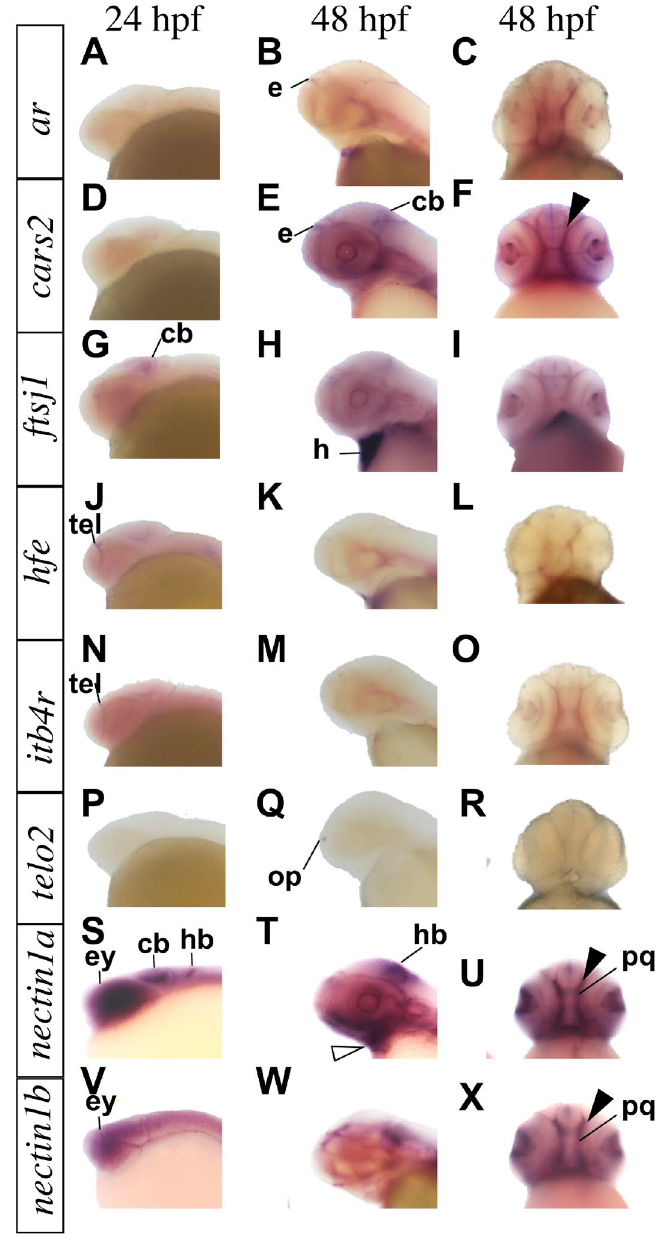
Figure 5. Whole-mount RNA in situ hybridization demonstrating genes expression in zebrafish. Genes expression pattern in lateral and ventral views at the indicated embryonic stages as hours per fertilization (hpf). cars2, nectin1a and nectin1b are expressed in zebrafish palate (solid arrow). nectin1a is expressed in the lower jaw at 48 hpf (hollow arrow). cb cerebellum, e epiphysis, ey eye, h heart, hb hindbrain, op olfactory placode, pq palate quadrate, tel